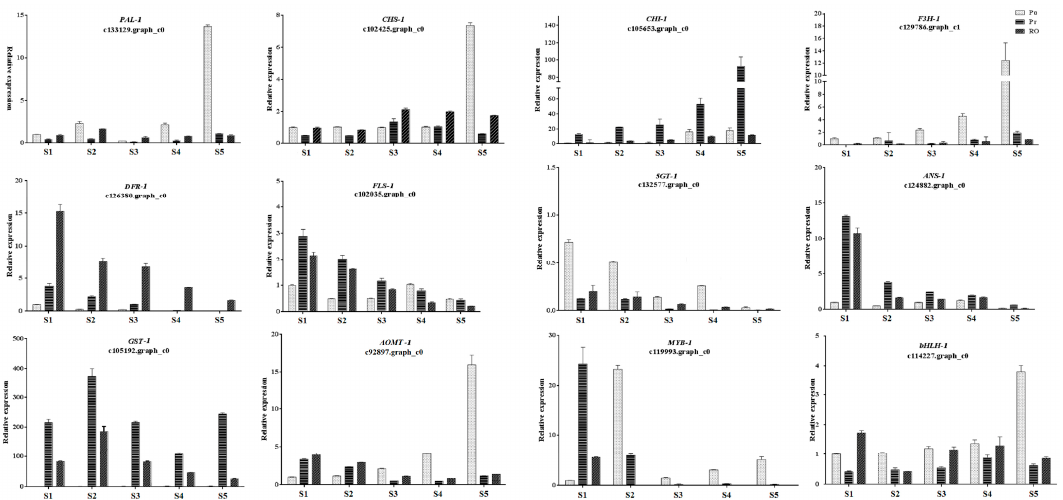
Figure 9. qRT-PCR analysis of twelve pigmentation-related candidate unigenes in the materials. The qRT-PCR analysis was performed using RNA from the petals at each floral developmental stages